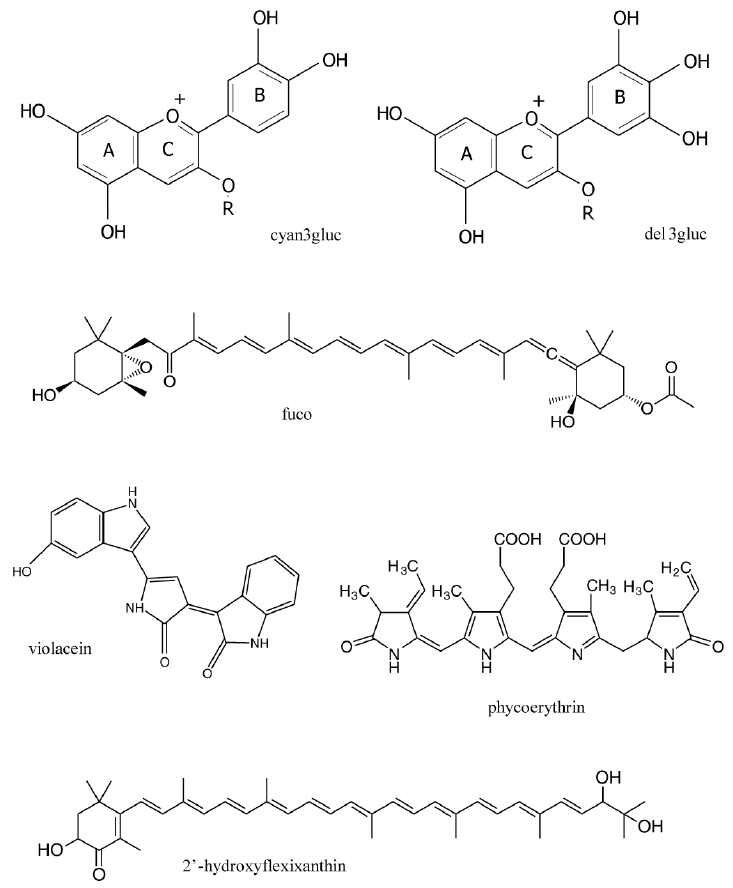
Figure 1. Chemical structures of the compounds mentioned in the text.